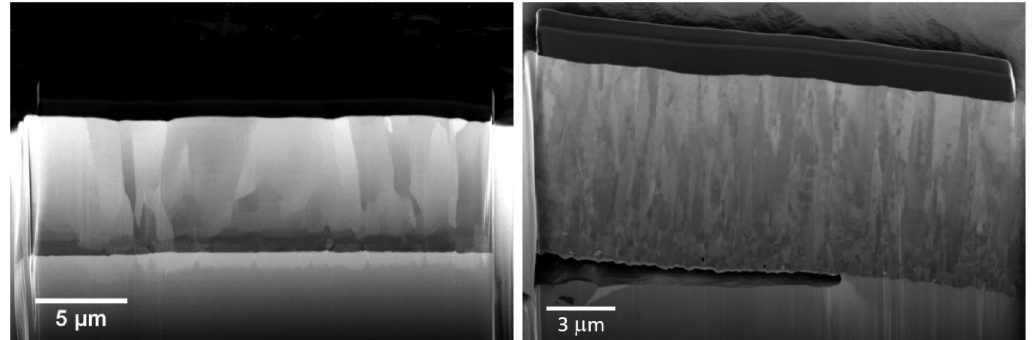
FIG. 4. FIB-SEM cross section images of HIE-ISOLDE coating at the middle of the antenna with − 80 V bias (left) and − 120 V bias (right) showing the delamination of the